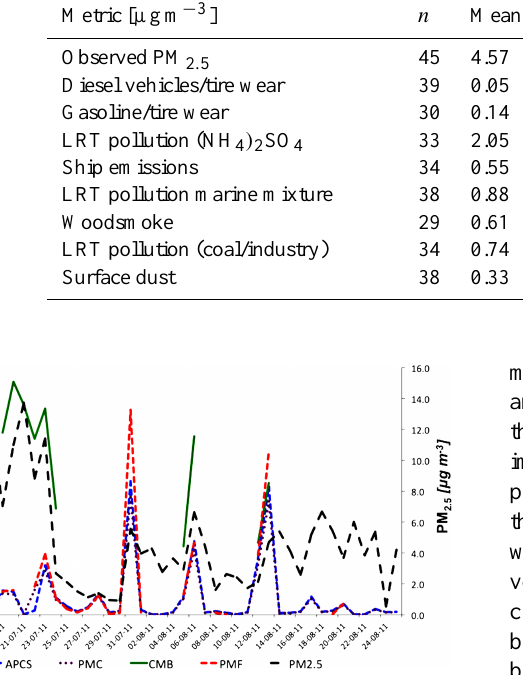
Figure 4. Time series of the woodsmoke contribution to the to- tal PM 2 . 5 mass estimated from the four receptor models during